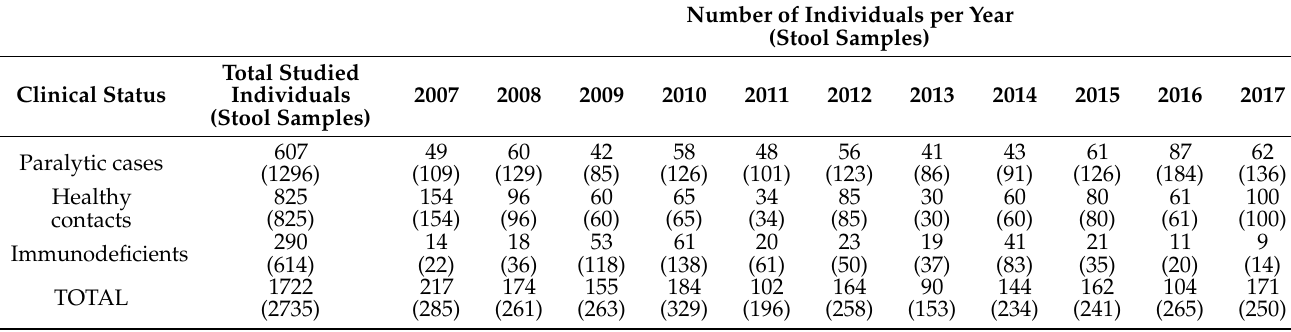
Table 1. Description of the studied population and stool sampling. Number of Individuals per Year (Stool